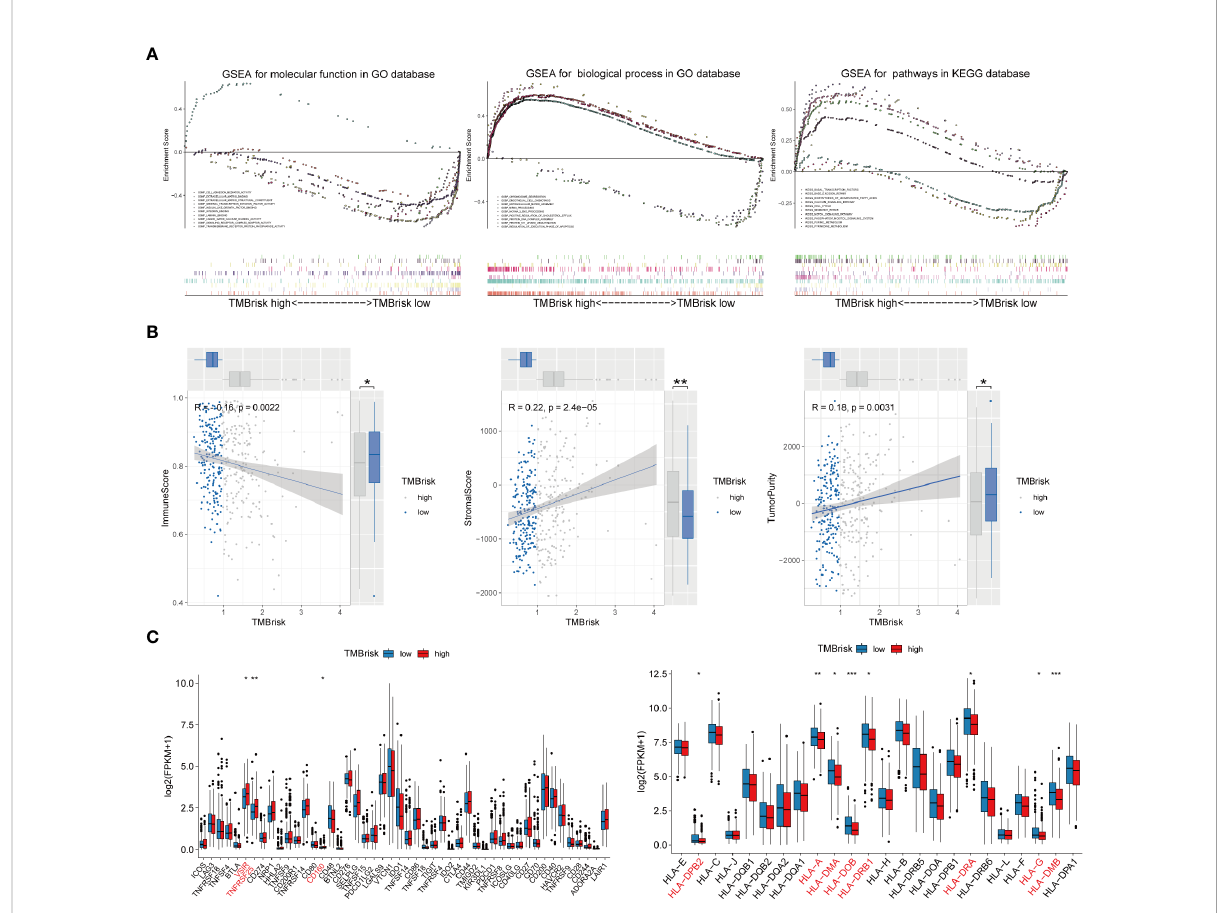
FIGURE 9 Function enrichment analysis for TMBrisk and correlation between TMBrisk and the expression of HLA family genes/immune checkpoints. (A) GO and KEGG enrichment of TMBrisk. In GSEA, patients were categorized into low- and high-TMBrisk groups. (B) Correlation between immune score, stromal score, tumor purity, and TMBrisk and their distribution in the low- and high-TMBrisk groups. (C) Analyses of the expression of immune checkpoints and HLA family genes in different TMBrisk groups. *p < 0.05; **p < 0.01; ***p < 0.001. TMB, tumor mutational burden; GO, gene ontology; KEGG, Kyoto Encyclopedia of Genes and Genomes; GSEA, gene set enrichment